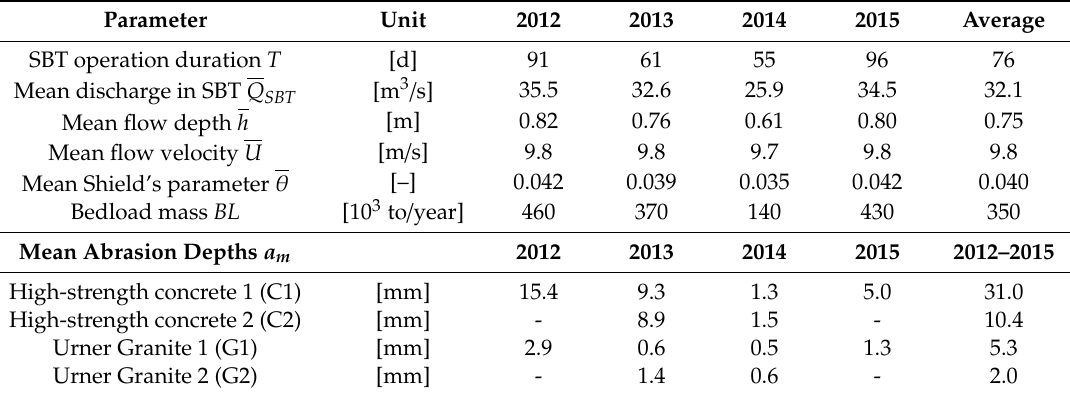
Table 4. Mean annual SBT operation conditions, bedload transport masses and abrasion depths in the Pfa ff ensprung SBT for the years 2012 to